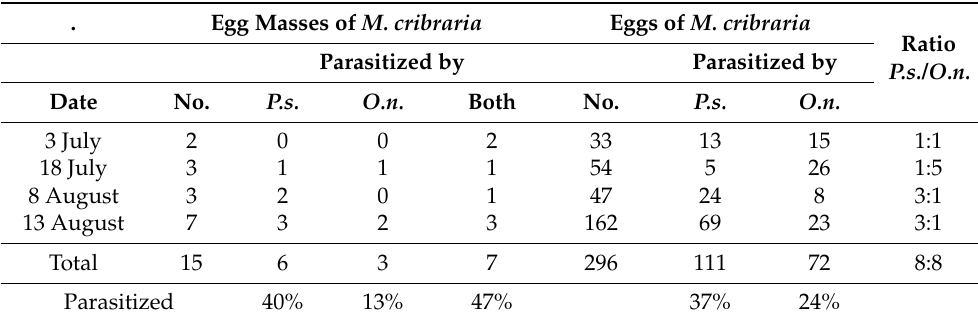
Table 4. Comparison of parasitism of egg masses and eggs from sites with both P. saccharalis (P.s.) and Ooencyrtus nezarae (O.n. ) in 2017.